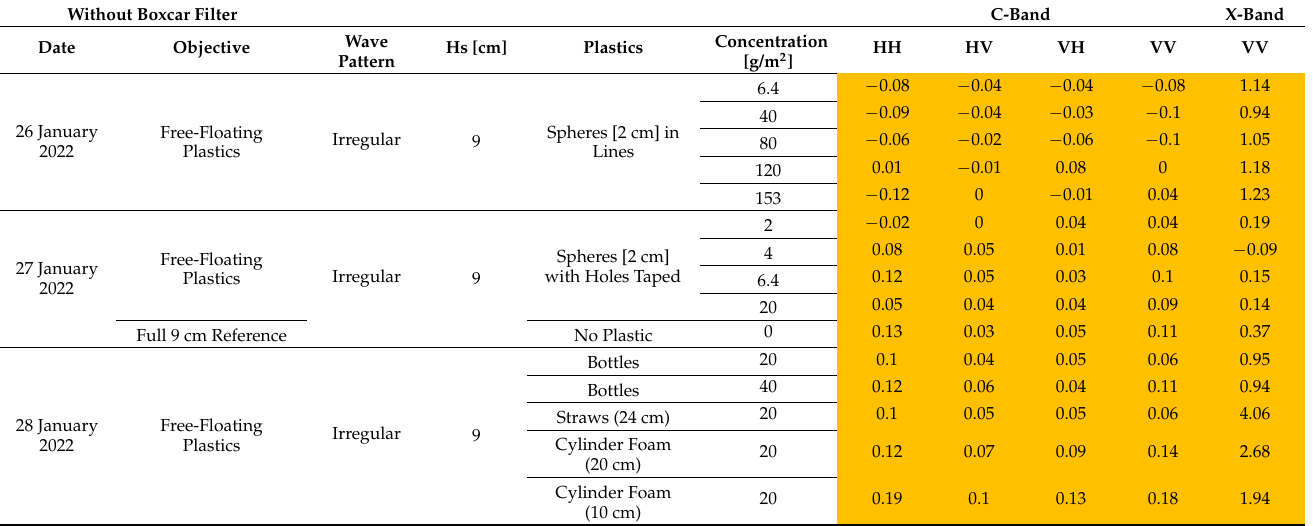
Table 5. Results of statistical analysis undertaken on 2nd campaign measurements without the use of a boxcar filter. Values filling the table are the results of the difference of the reference measurement and test measurement in a linear format. Any value in green shows that the alternative hypothesis was fulfilled; any value in orange shows that the null hypothesis was